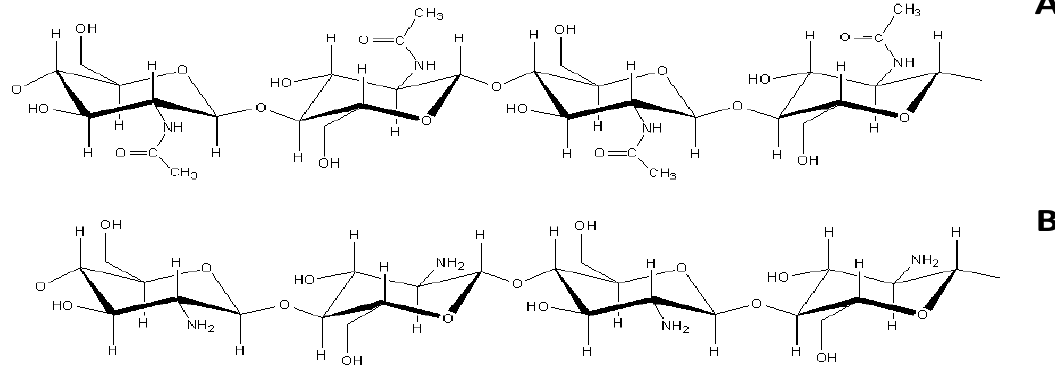
Figure 1. ( A ) Chemical structure of chitin; ( B ) Chemical structure of chitosan.